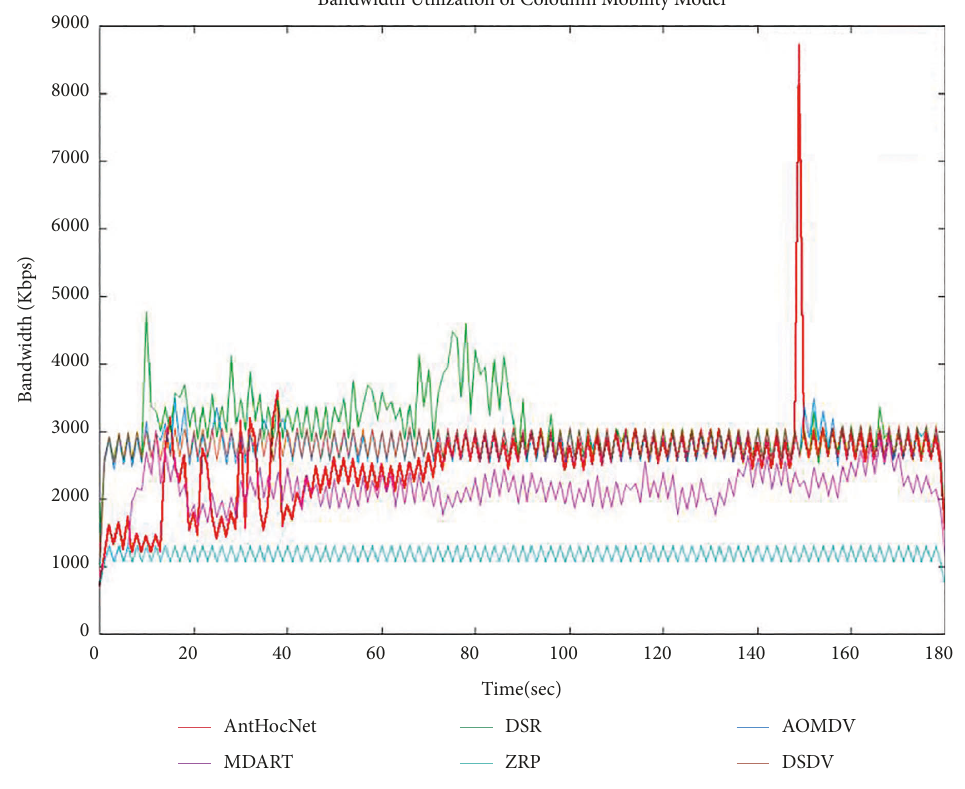
Figure 7: Packet drop rate for column mobility